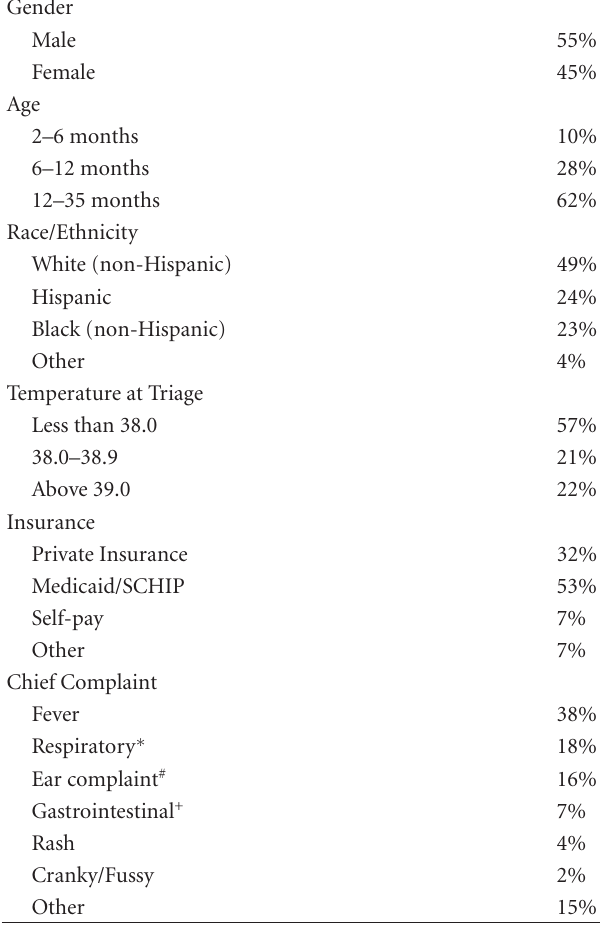
Table 1: Description of patients diagnosed with acute otitis media.